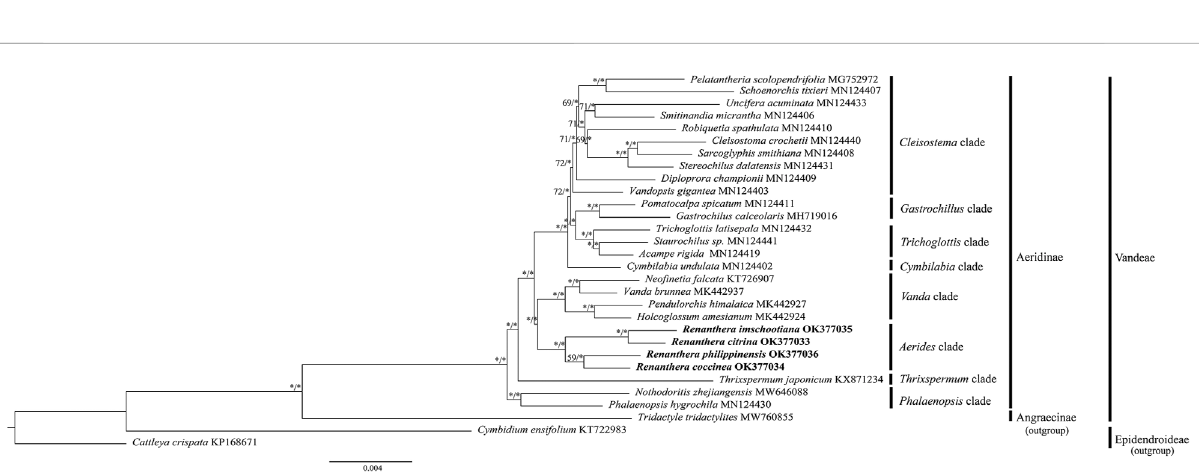
FIGURE 6 Phylogenetic trees based on CDS sequences of 30 species of Orchidaceae. Three species, Tridactyle tridactylites (Angraecinae, Vandeae; MW760855), Cattleya crispata (Epidendroideae; KP168671), and Cymbidium ensifolium (Epidendroideae; KT722983) were included as outgroups. Numbers on each node represent bootstrap support (BS) and posterior probability (PP) values. Branches indicated with BS ≥ 75 and PP ≥ 0.90 are considered as well-supported, which are represented with an asterisk